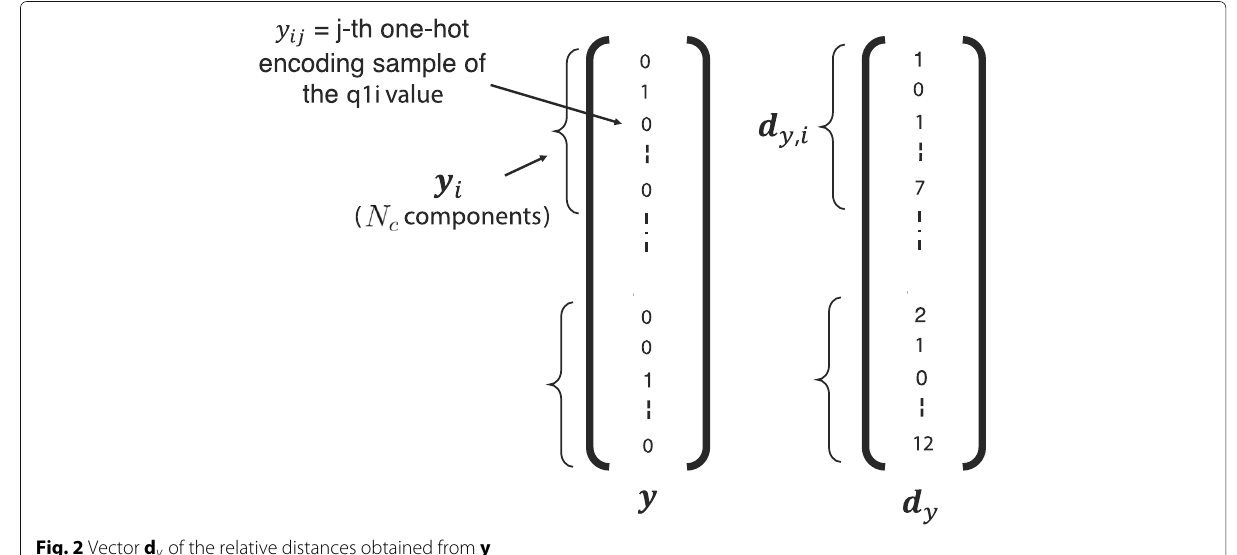
Fig. 2 Vector d y of the relative distances obtained from y